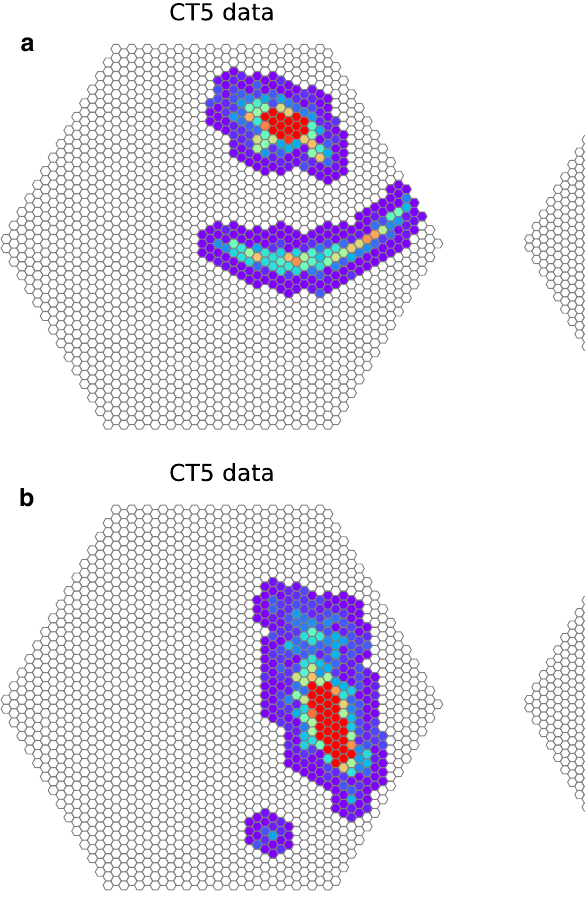
arc, whereas the additional feature in the image in panel “b” is much smaller and has a simpler shape. However, the maximum pixel intensity in this feature is more than double what is expected from NSB noise. Note that the colorbar has been restricted so that the fainter features